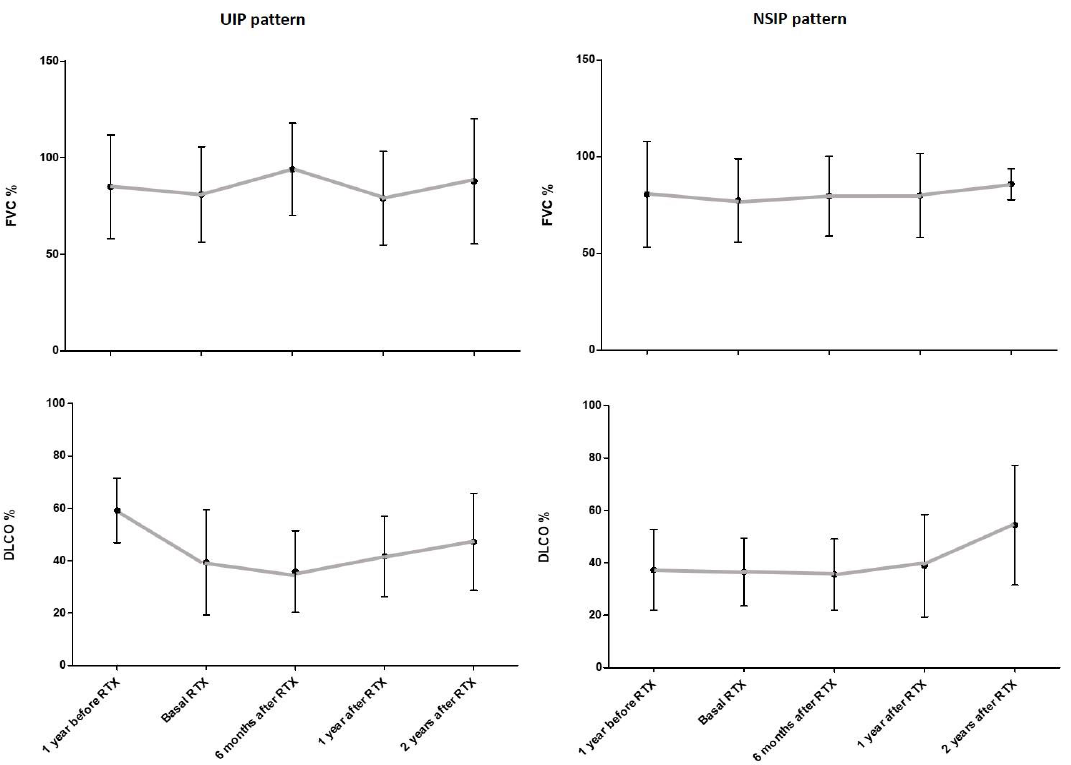
Figure 2. Evolution of FVC and DLCO values in AD-ILD patients included in this study according to their UIP and NSIP HRCT patterns. Bars indicate mean value and standard deviation for each time point. AD: autoimmune disease; DLCO: diffusing capacity of the lungs for carbon monoxide; FVC: forced vital capacity; HRCT: high-resolution computed tomography; ILD: interstitial lung disease; NSIP: non-specific interstitial pneumonia; RTX: rituximab; UIP: usual interstitial pneumonia.